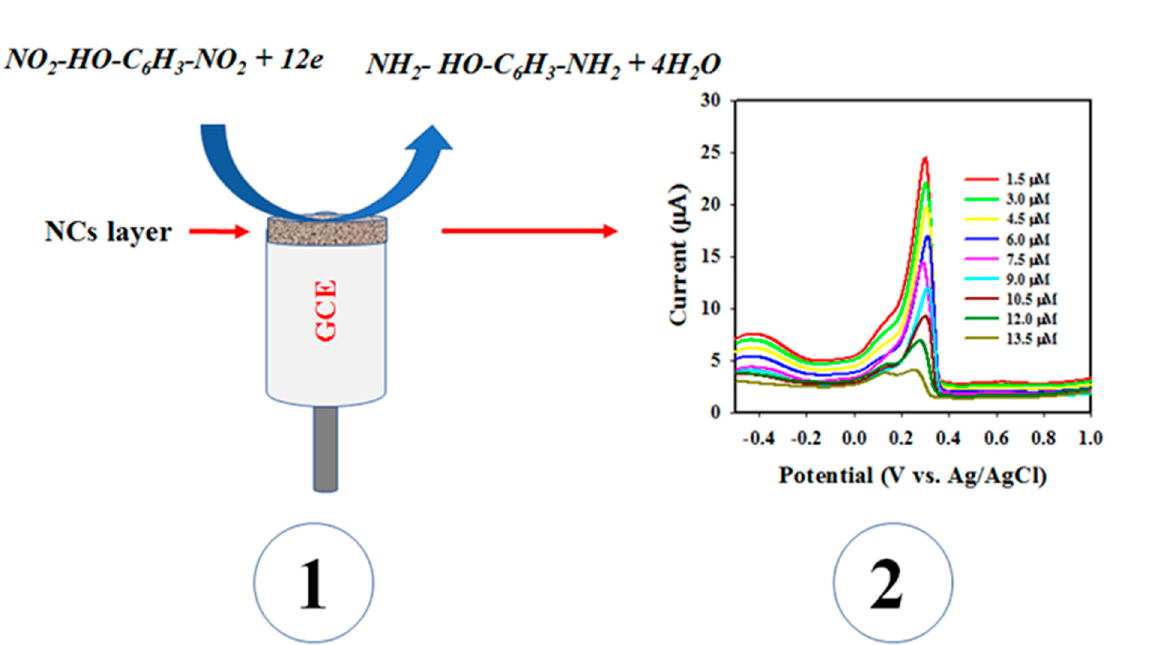
Scheme 1. Schematic representation of chemical sensing with Ag-decorated Chitosan/SrSnO 3 NC/GCE. ( 1 ) Electrochemical reduction of 2,6-DNP and ( 2 ) Concentration-based responses of 2,6-